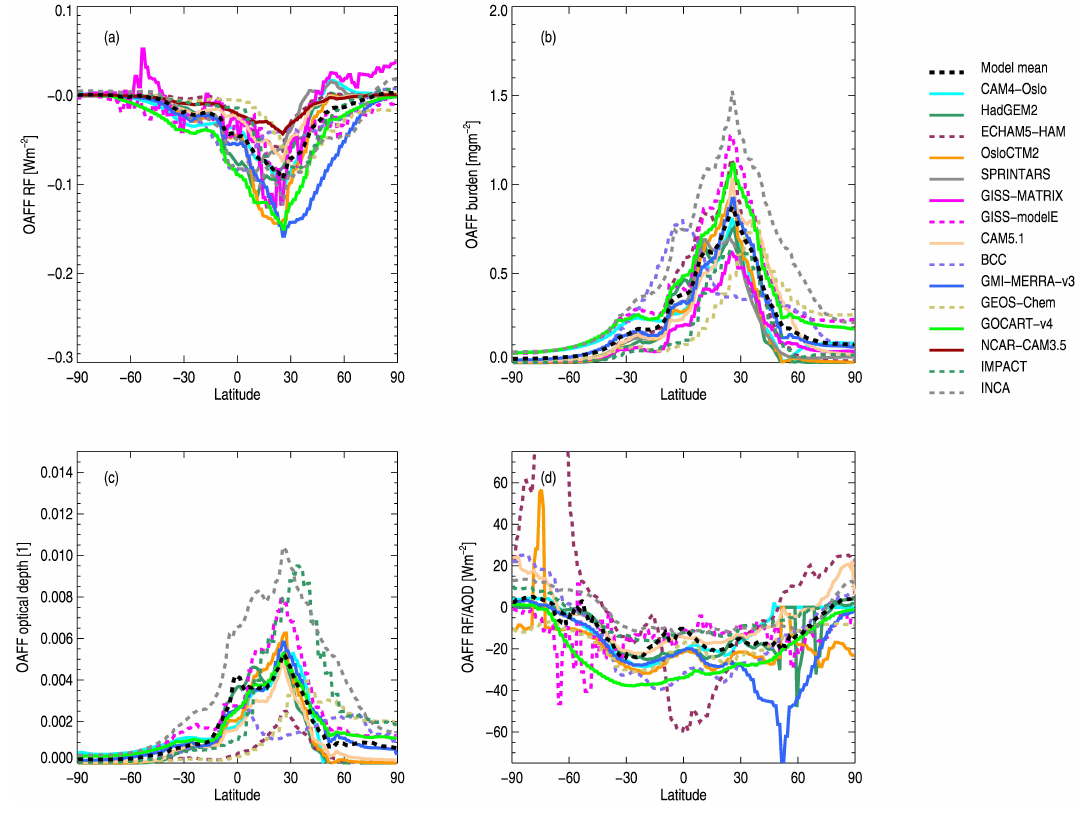
Fig. 10. Zonal mean OAFF RF (a) , burden (b) , AOD at 550nm (c) , NRF(A) (d) . Table 7. Same as Table 4 for